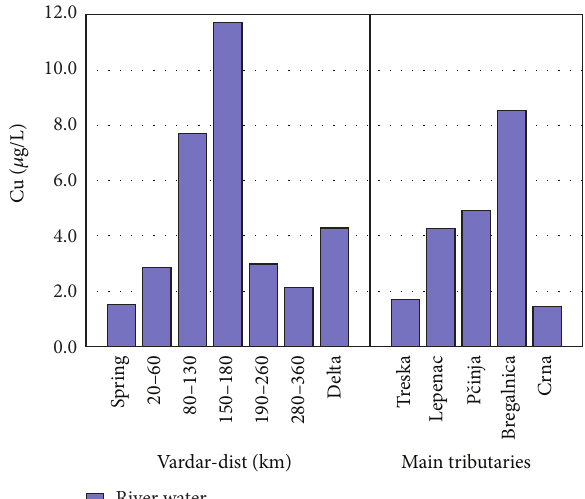
Figure 5: Concentration of Cu found in river Vardar and main tributaries.